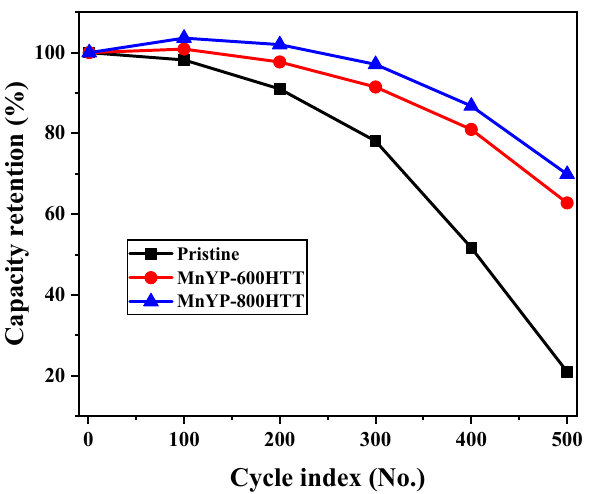
Figure 11. Cycling test of Pristine, Mn-doped MnYP-600HTT and MnYP-800HTT under 500 cycles.